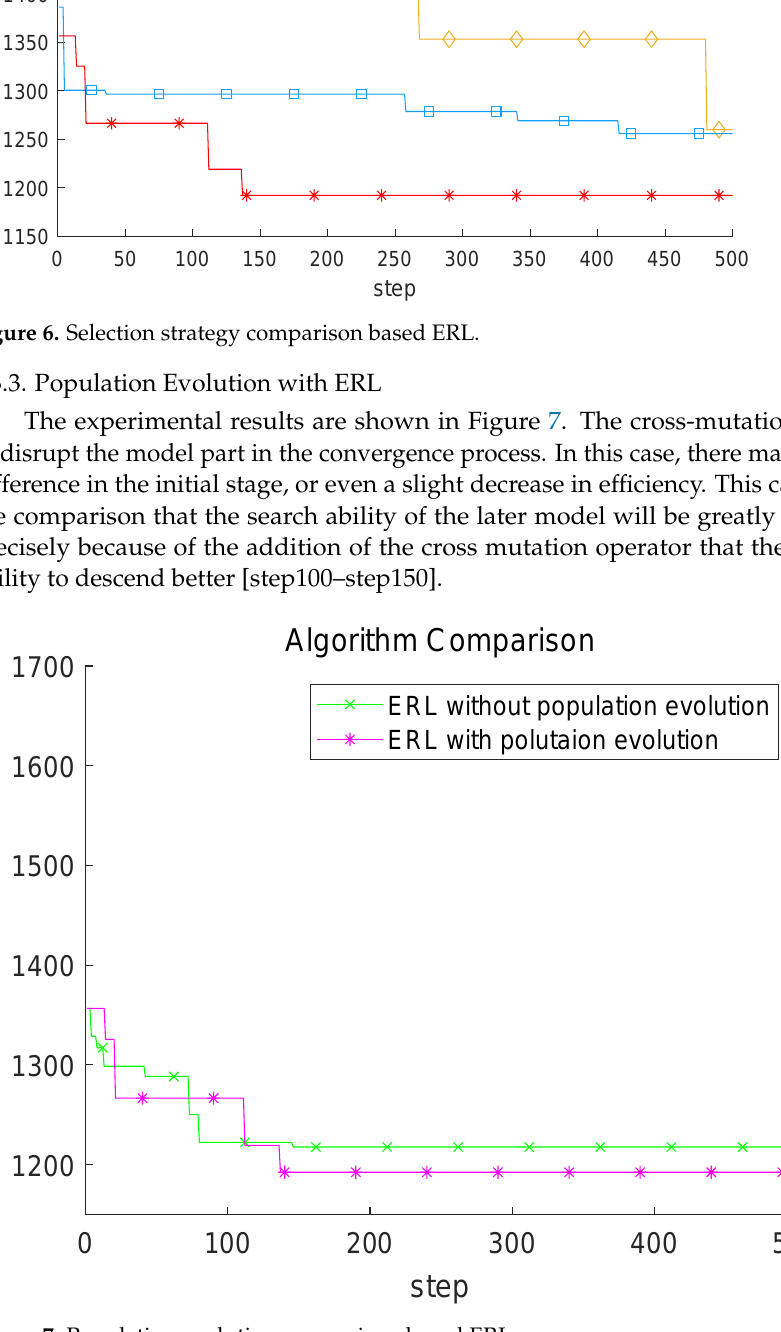
Figure 7. Population evolution comparison-based